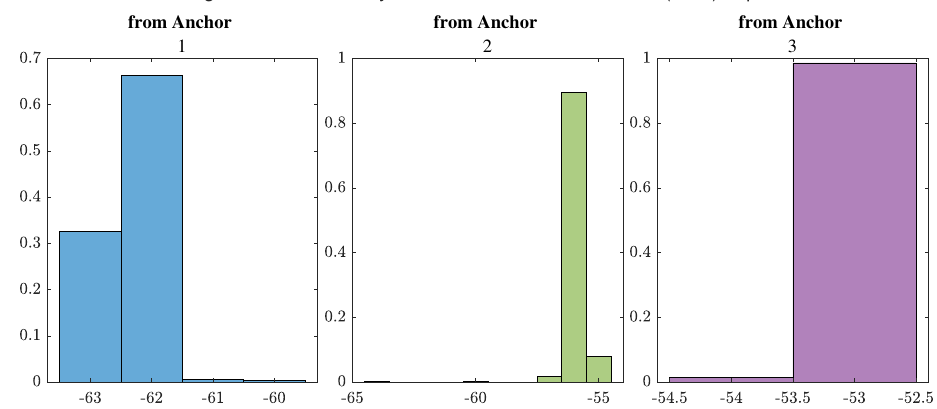
Figure 13. Distribution of Received Signal Strength (RSS) values received from WiFi anchors at point